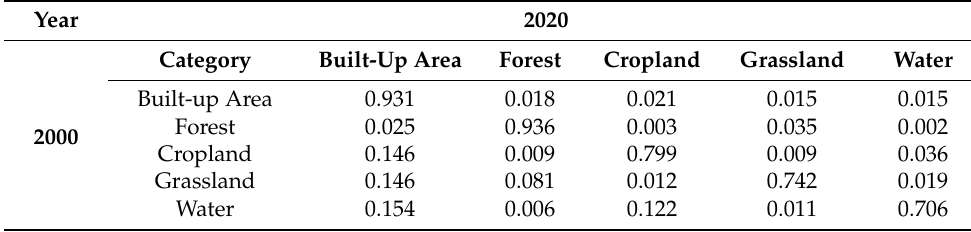
Table 10. Transition Matrix from 2000–2020.